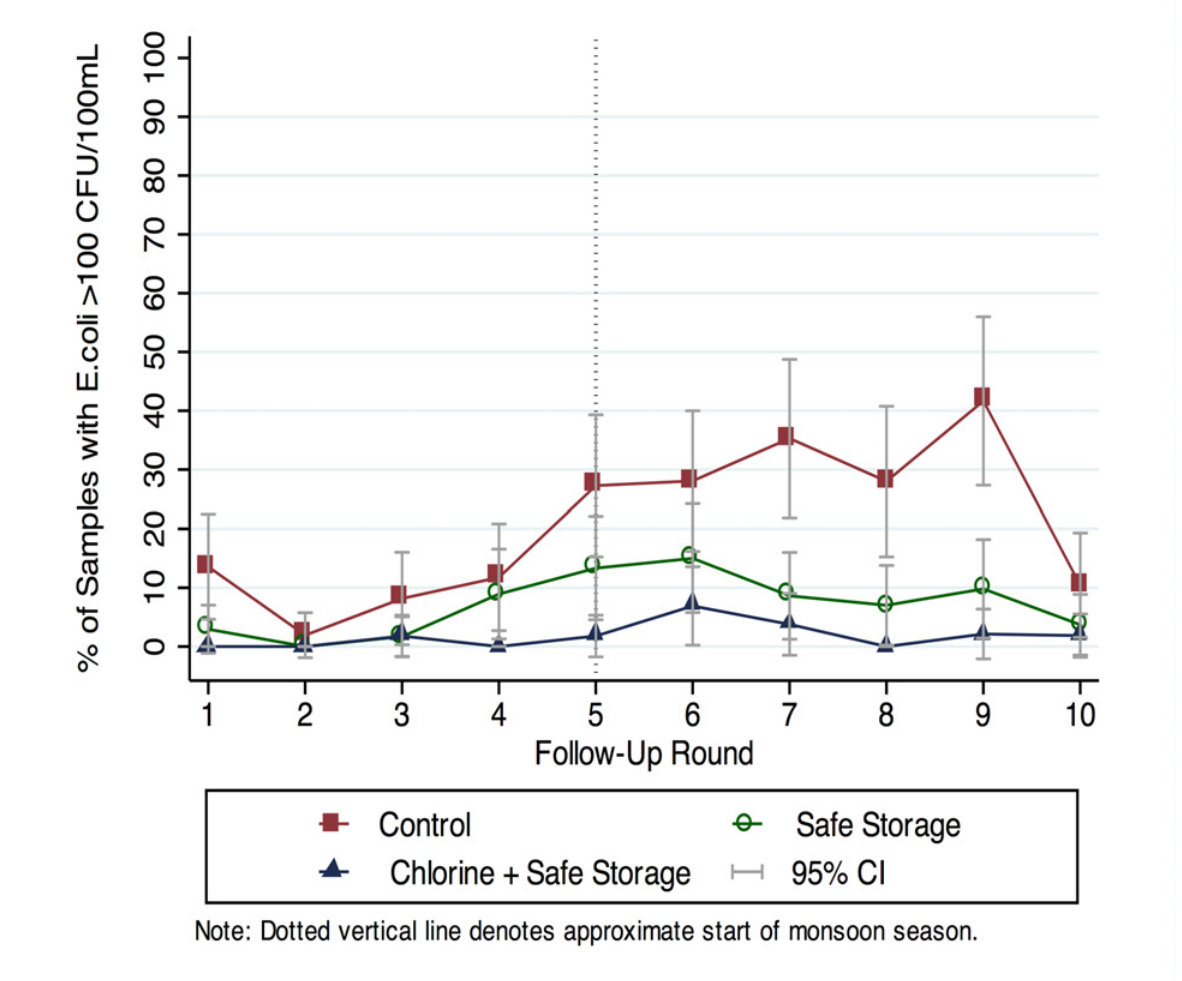
Fig 5. Temporal trend in percentage of stored water samples with E . coli > 100 CFU/100